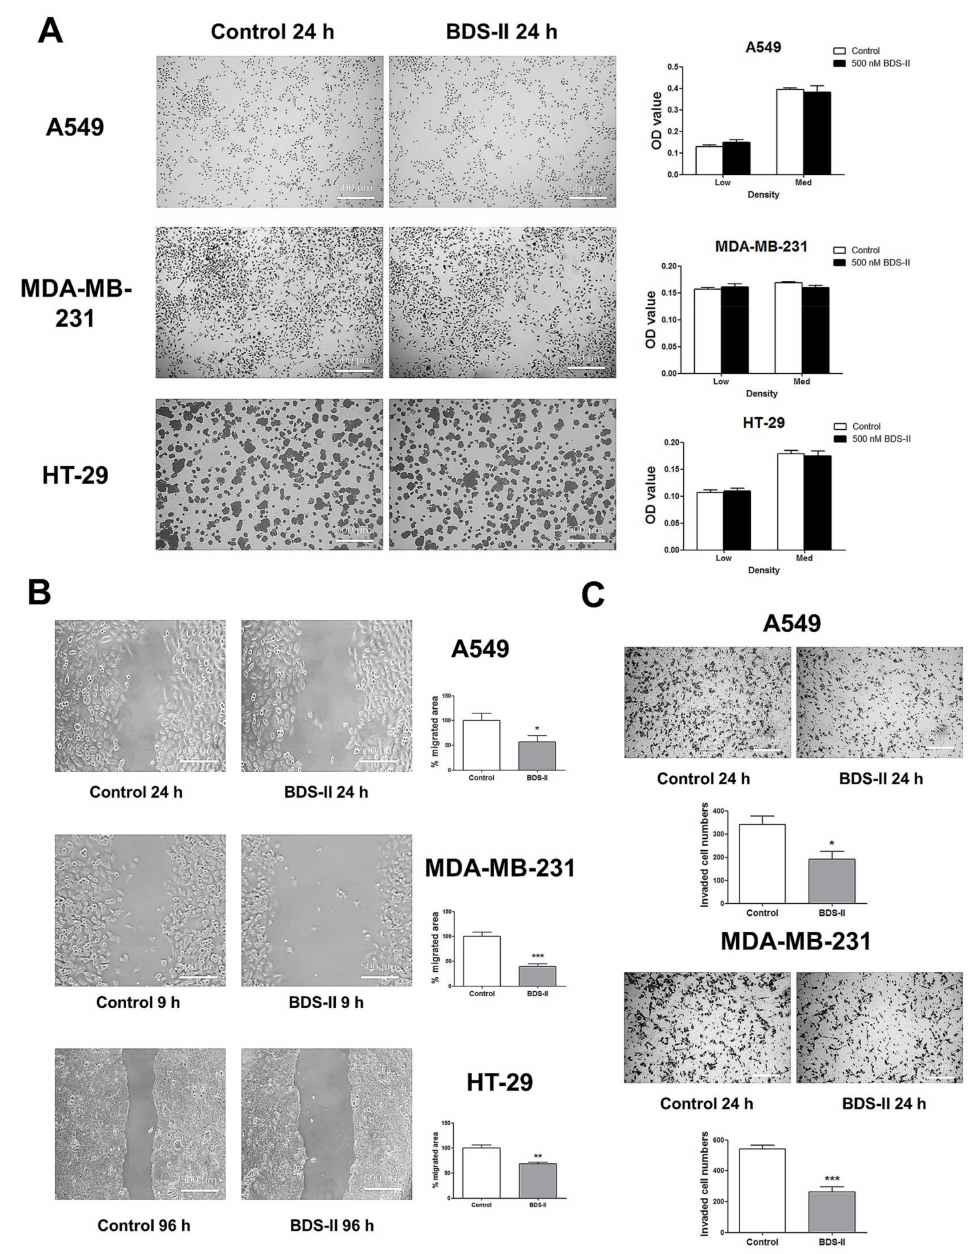
Figure 4. Effect of BDS-II on cell proliferation, migration, and invasion. ( A ) Representative Hemacolor ® rapid staining images demonstrate that 24 h of BDS-II (500 nM) treatment did not affect the proliferation of A549, MDA-MB-231, and HT-29 cells. The MTT data also demonstrated that BDS-II did not affect cell proliferation in the three cell lines. ( B ) Representative images demonstrate that 500 nM BDS-II significantly inhibited migration by almost half in A549, MDA-MB-231, and HT-29 cells. ( C ) Hemacolor ® rapid staining images demonstrate that the number of cells that migrated through the membrane was reduced in A549 and MDA-MB-231 cells by 500 nM BDS-II treatment. All experiments were performed in triplicate or quadruplicate, and the data represent the mean ± standard error. * p < 0.05, ** p < 0.01, and *** p < 0.001 versus the control